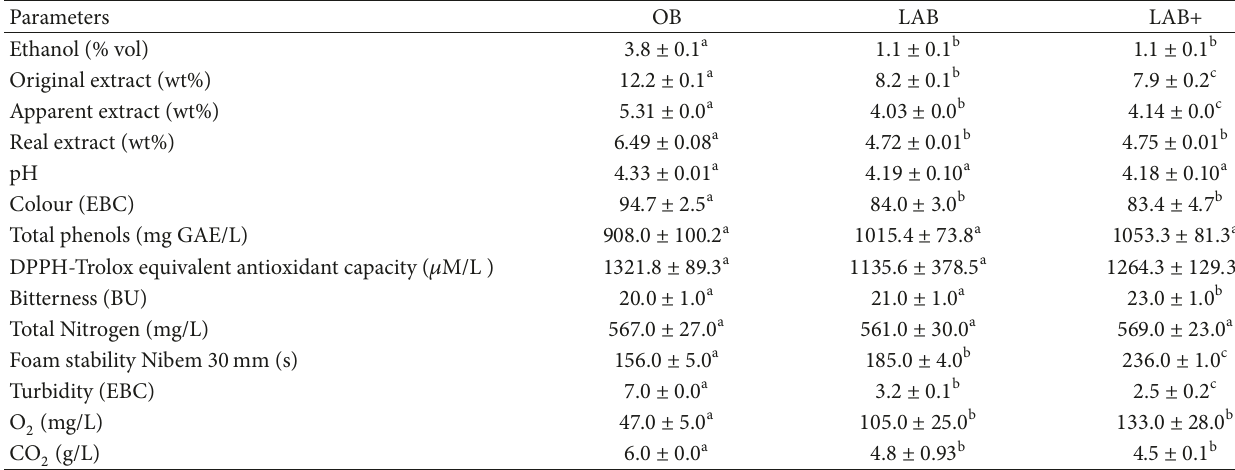
Table 3: Quality parameters of original beer (OB), low alcohol beer (LAB), and low alcohol beer added with hop extract and pectin solution